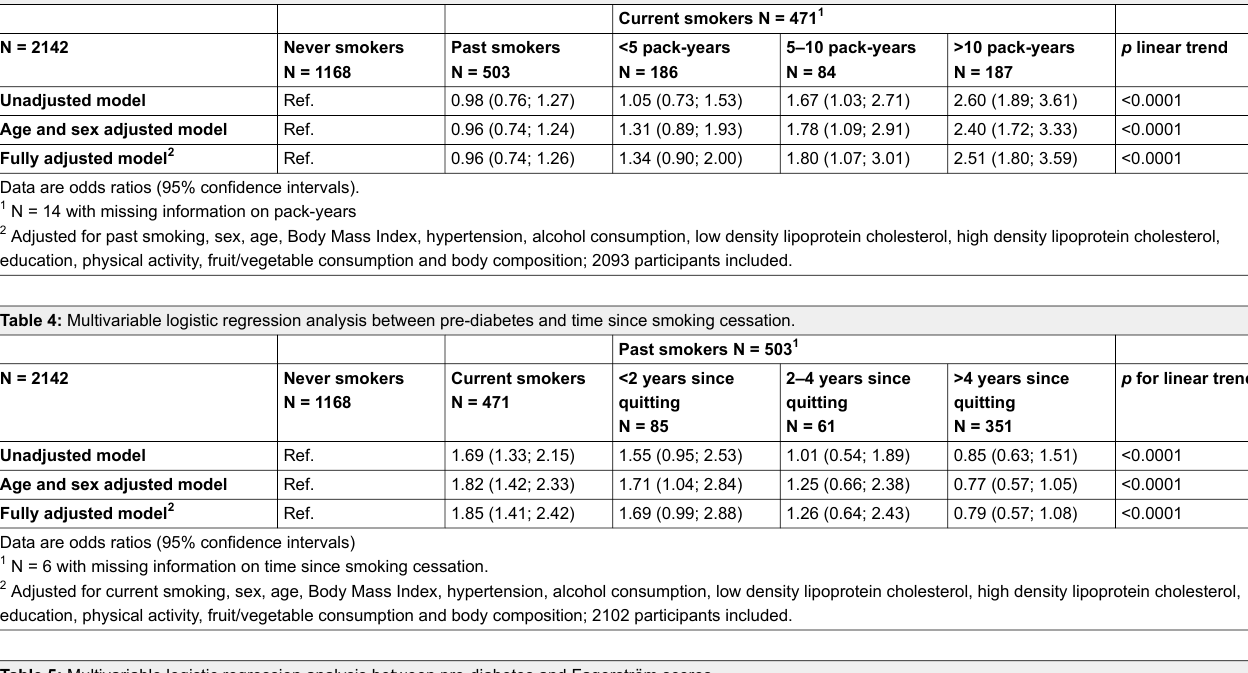
Table 3: Multivariable logistic regression analysis between pre-diabetes and pack-years of smoking.